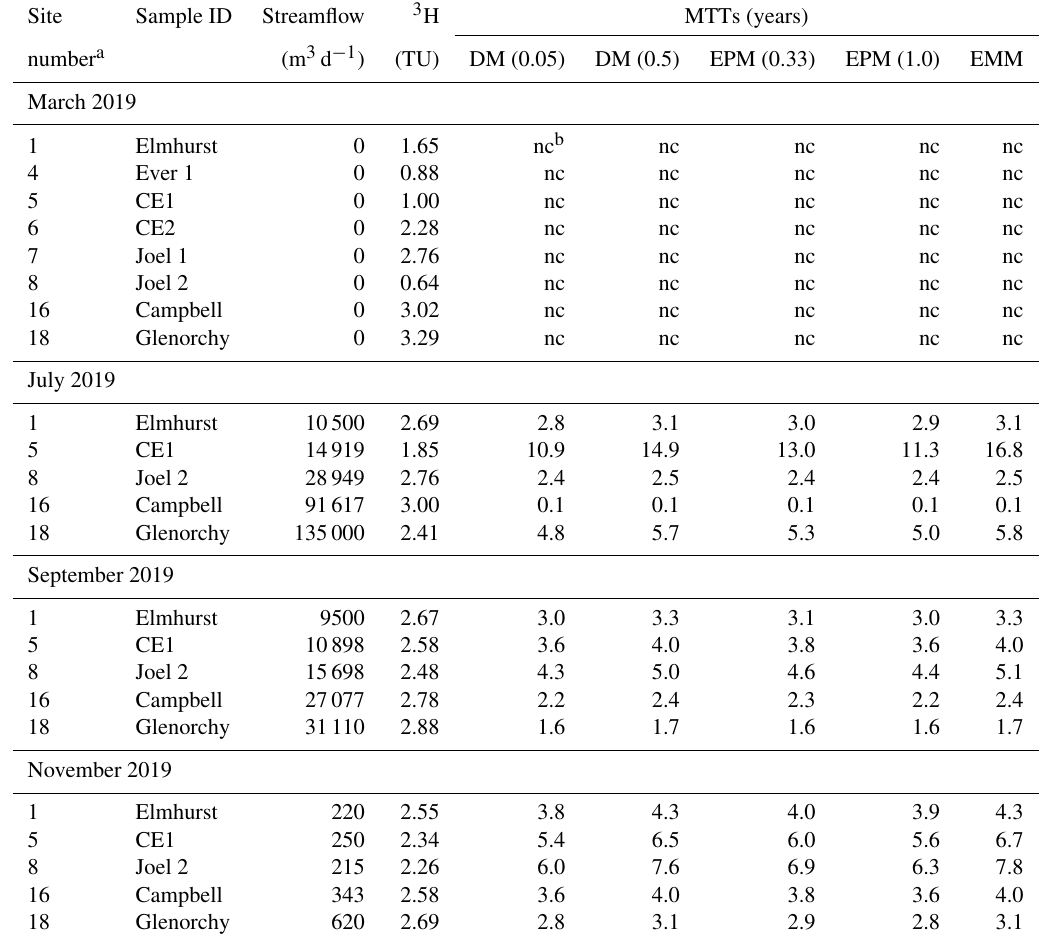
Table 1. 3 H activities and calculated mean transit times (MTTs) from pool water and stream water of upper Wimmera